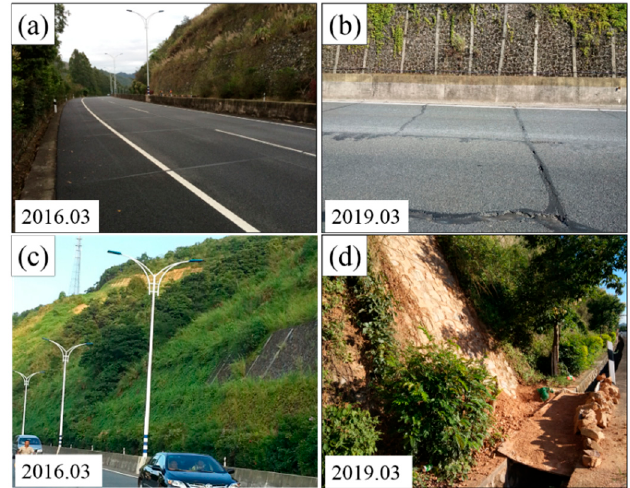
Figure 4. Distresses development in the test sites: ( a ) performance of the embankment and roadbed of S223 in 2016; ( b ) performance of the embankment and roadbed of S223 in 2019; ( c ) performance of the slope of S270 in 2016; and ( d ) performance of the slope of S270 in 2019.